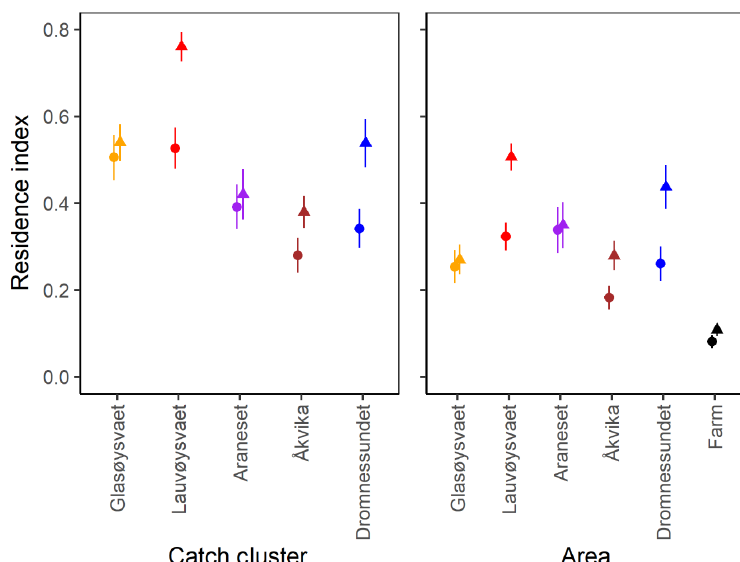
Fig. 3. Residence index during the spawning period for cod using catch clus- ters as grouping variable (left panel) and using spawning ground as grouping variable (right panel) for females (circles) and males (triangles). Points: mean values; error bars: